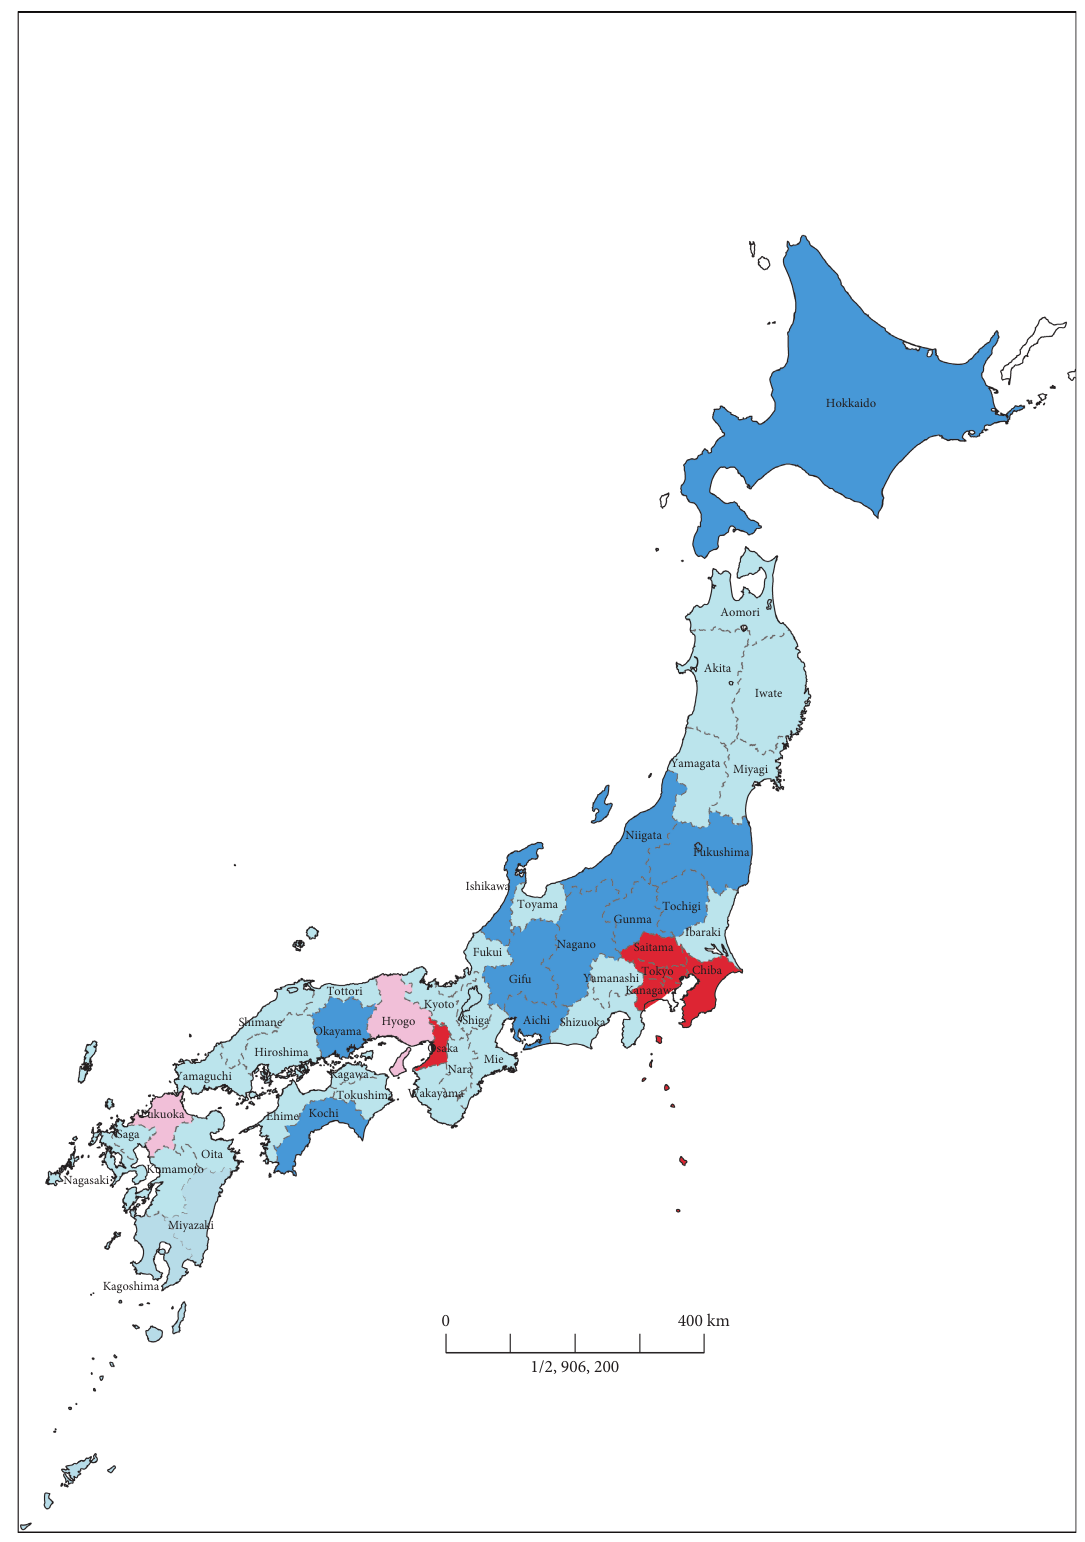
Figure 2: Issuance of the state of emergency by the Japanese government. The early group prefectures, in which the state of emergency was issued on April 7, 2020, are shown in shades of red. The late group prefectures, in which emergency was declared on April 16, 2020, are shown in blue. Although not included in this study, other prefectures where the state of emergency was issued early are shown in light pink, and the prefectures where the state of emergency was issued late are shown in light